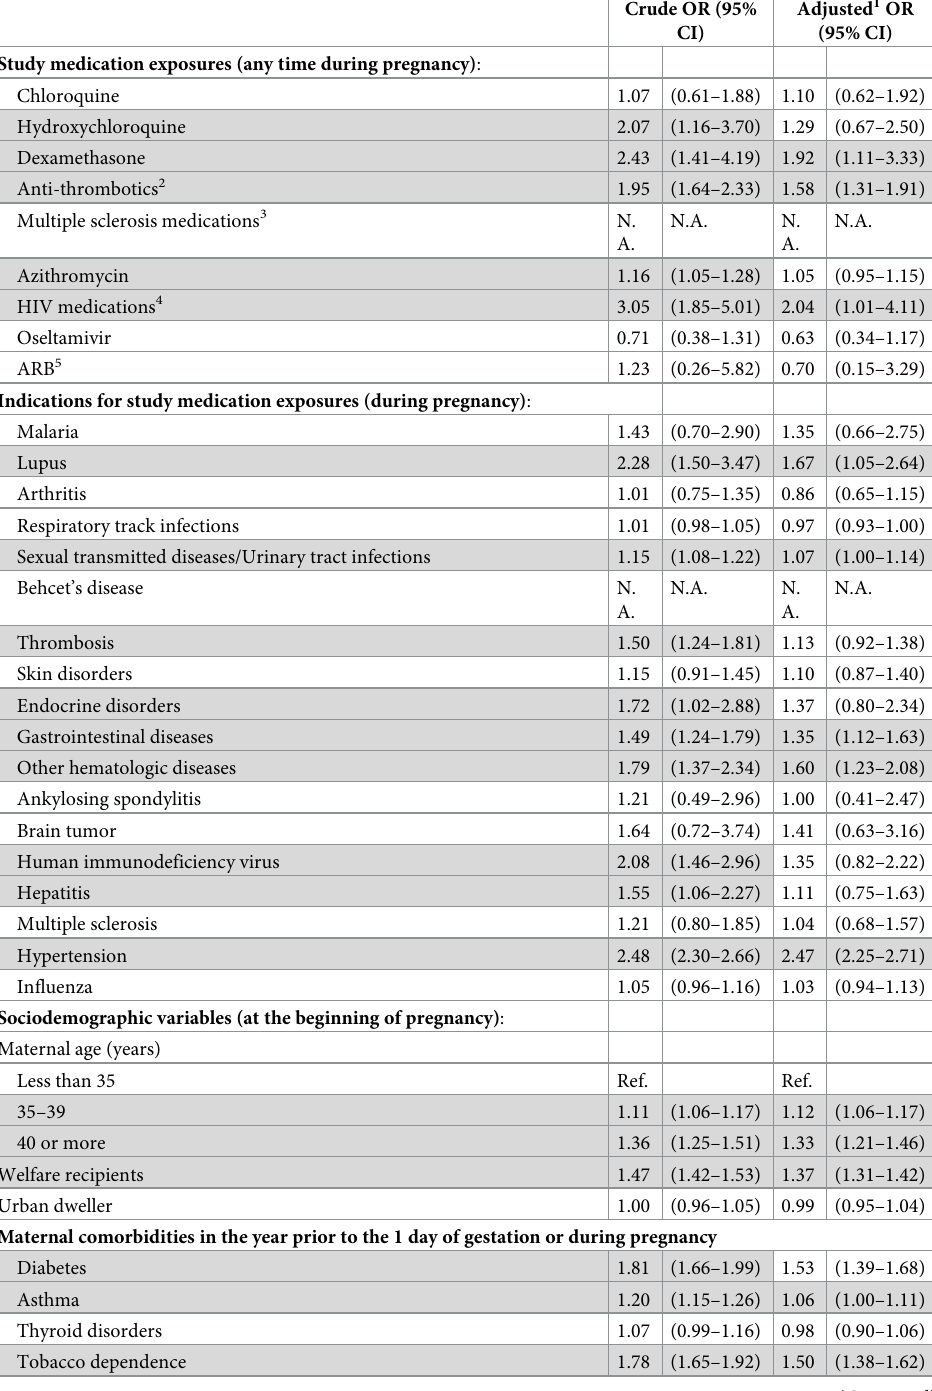
Table 2. A. Association between study medication exposures during pregnancy and the risk of prematurity. B. Asso- ciation between study medication exposures during pregnancy and the risk of low birth weight (LBW) (birthweigh < 2500 grams). C. Association between study medication exposures during pregnancy and the risk of being born small for gestational age (SGA) (birthweight below the 10th percentile for newborns of the same gestational age and same sex). D. Association between study medication exposures during the first trimester of pregnancy and the risk of overall major congenital